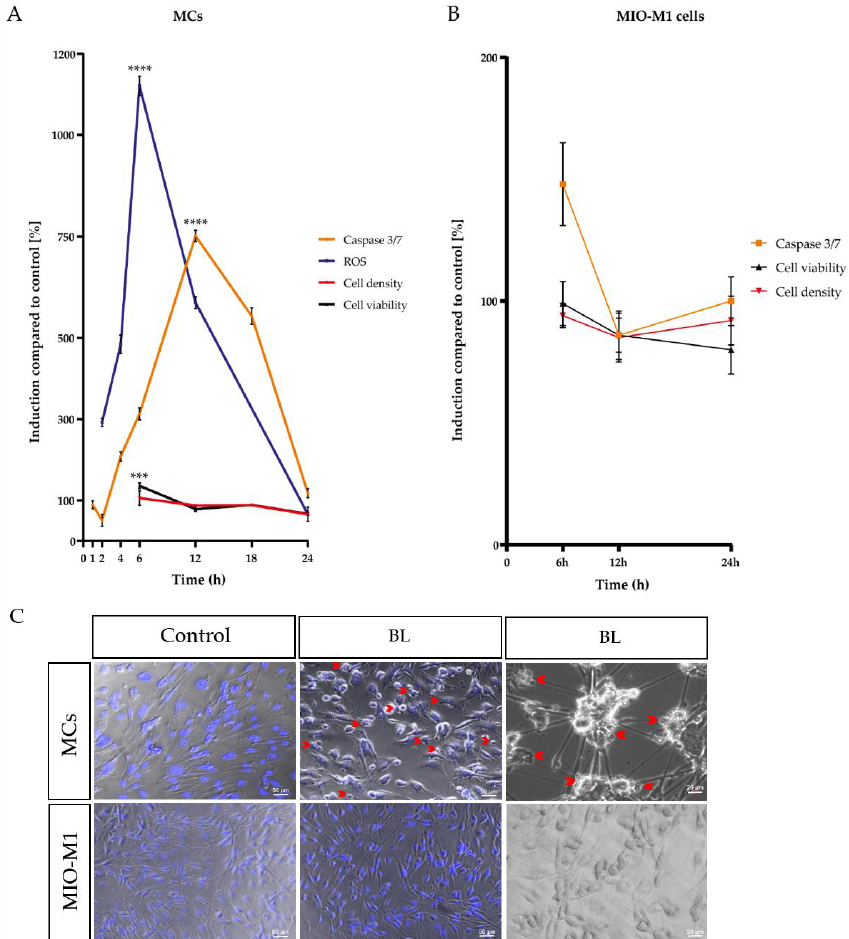
Figure 1. Time course of blue light (BL)-induced processes in Müller cell-derived cells and human MIO-M1 cells. Caspase 3/7 activity, cell viability, and cell density were measured after 1.5 h BL exposure in ( A ) Müller cell-derived cells (MCs) over time compared to a 100% set control. H 2 O 2 levels increased rapidly with a peak after 6 h, followed by enhanced caspase 3/7 activity with a peak at 12 h. Cell viability and density decreased after 24 h, indicating apoptosis as the primary cell death pathway. ( B ) MIO-M1 cells only had a slight increase in caspase 3/7 activity after 6 h. Cell viability and density levels were similar to control levels 24 h after exposure. ( C ) Morphological analysis revealed apoptotic blebbing (red arrows), cell shrinkage, and condensed nuclei (Hoechst staining: blue) in BL-exposed MCs 24 h after exposure (compared to unexposed control). In contrast, BL exposure did not induce apoptotic blebbing or condensed nuclei in MIO-M1 cells. Bar graphs represent the mean values and SEM. The control was set to 100%, and induction was compared to control levels. Original data are provided in Table S1; n = 5–15, repeated three times. Statistical differences are indicated as follows: *** p < 0.001, and **** p < 0.0001 compared to control, according to Welch’s one-way